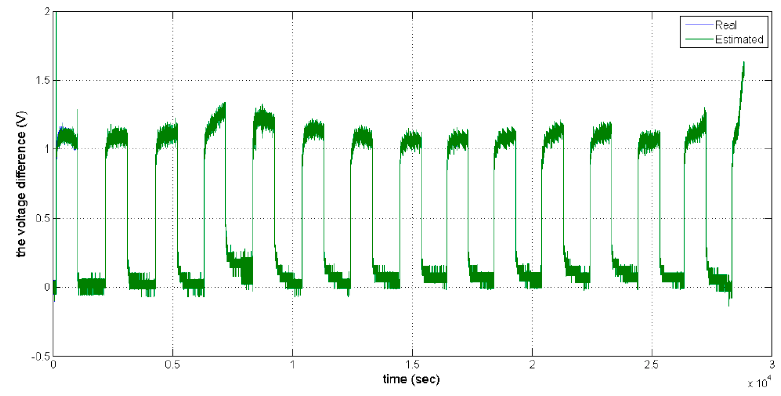
Figure 8. The parameter estimation using variable forgetting factor.